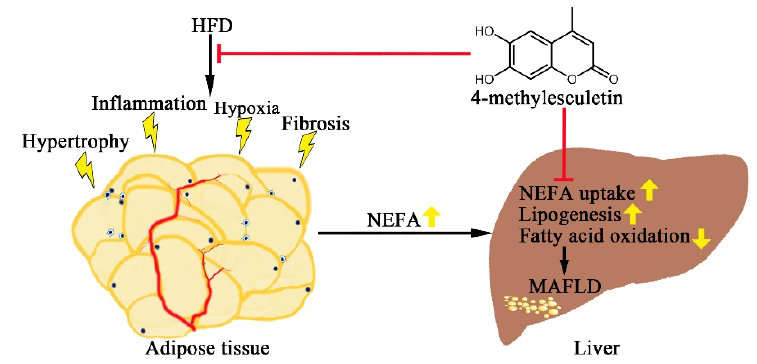
Figure 6. A depiction of effects of 4-ME upon obesity and MAFLD.